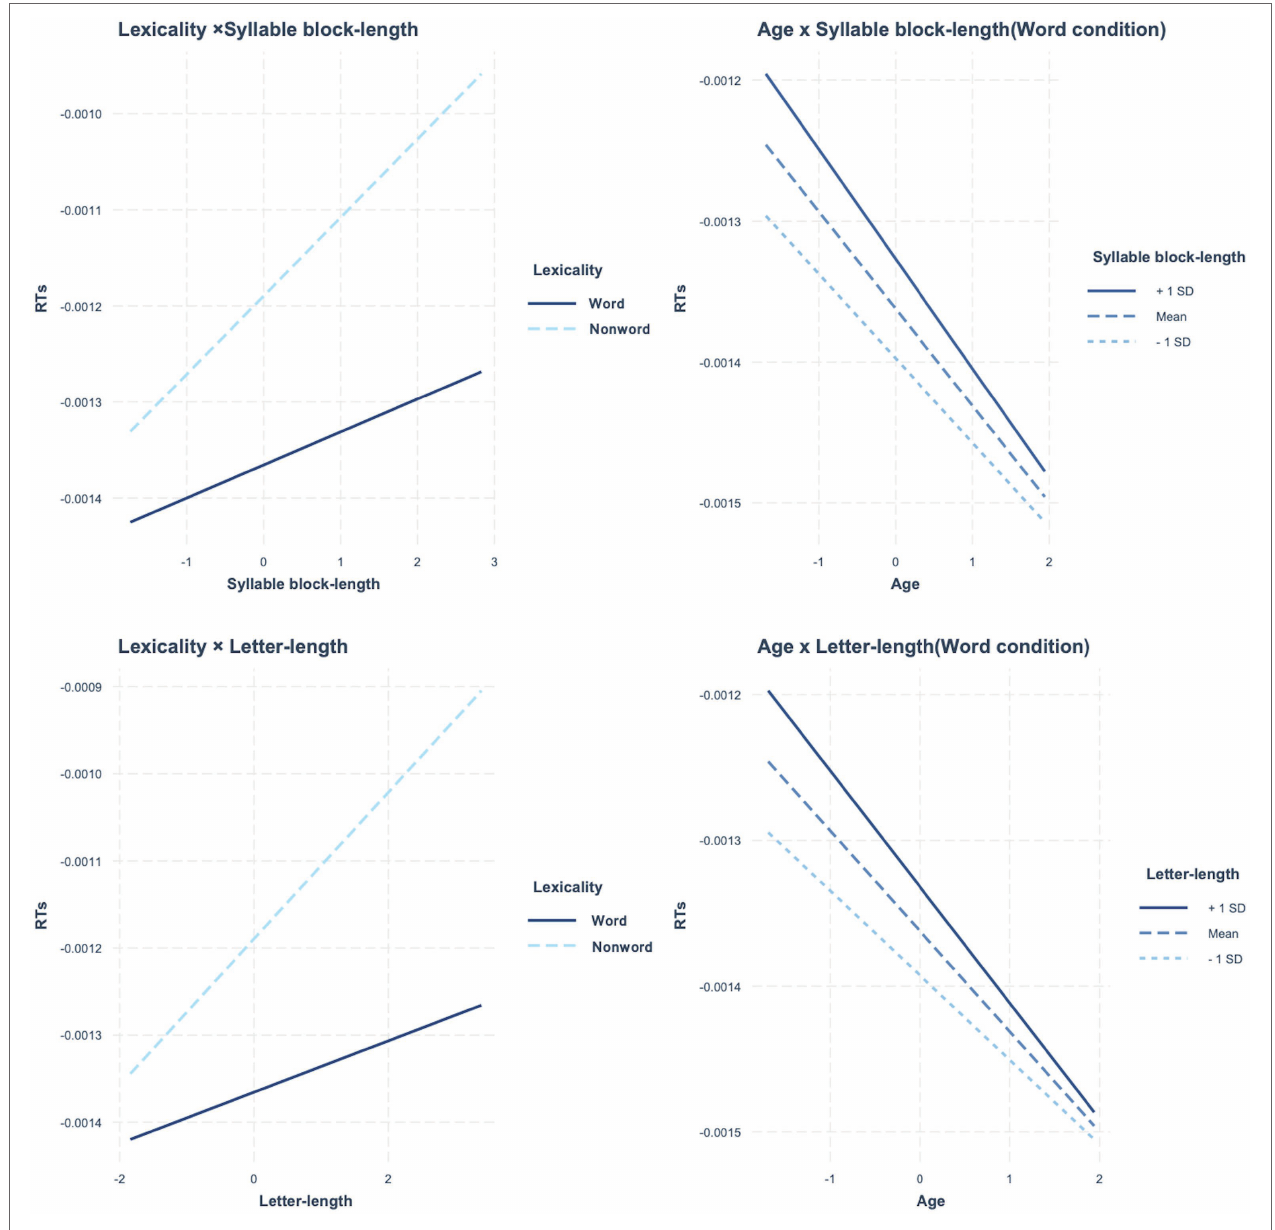
FIGURE 3 | In reading latency, significant interactions between lexicality and two types of length, and between age and length. Left panels : interaction between lexicality and two types of length. Right panels : interaction between age and length in word condition, related to the three-way